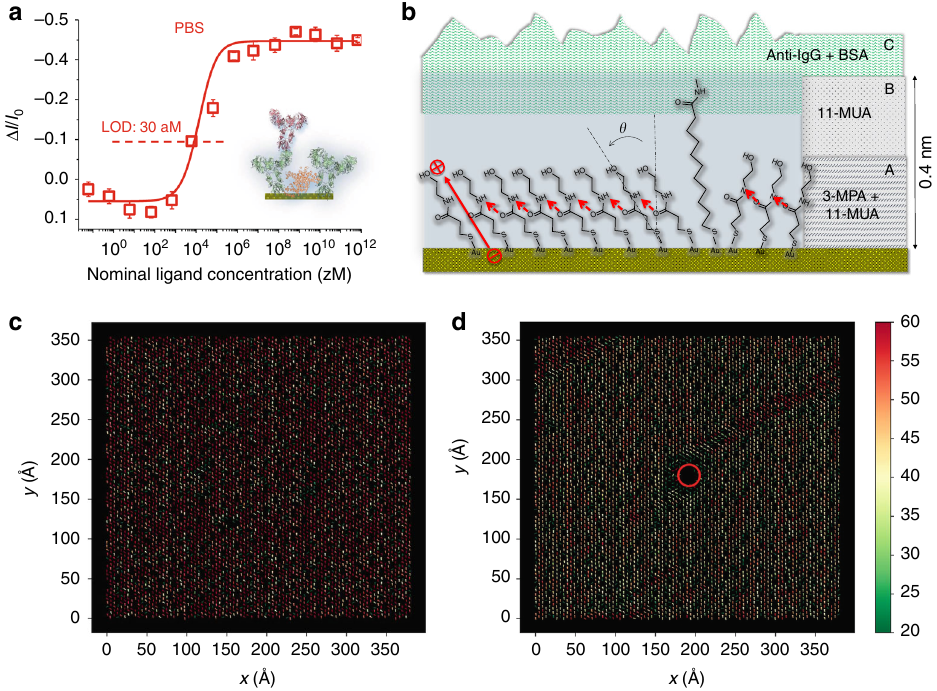
Fig. 4 The chem-SAM work function change. In ( a ) the dose – response curve of the IgG assay measured with the gate covered by the sole bio-SAM directly physisorbed on the gold surface, is given. The fi tting of the IgG binding curve with Supplementary Eq. 20, derived in Supplementary Note 7, is shown as red solid line. In ( b ) detailed illustration of the chem-SAM is provided, with the H-Bonds visualized as red dashed arrows. The angle θ is de fi ned by the vector originating from the sulfur atom and pointing towards the oxydril oxygen atom of activated and blocked 3-MPA chain and the z -axis normal to the gate surface plane and aligned with the gating fi eld. In ( c ) the direction and the occupancy (%) of the H-bonds resulting from the analysis of MD trajectories are shown under the gating- fi eld. The color codes indicate the percentage of frames in which the H-bond is established. In ( d ) the simulation is carried out on the same system but a defect mimicking the impact of the af fi nity binding event is simulated by imposing as coordinates of the central circular region (red circle) a disordered conformation (stably missing of H-bonds). See Supplementary Note 11 for